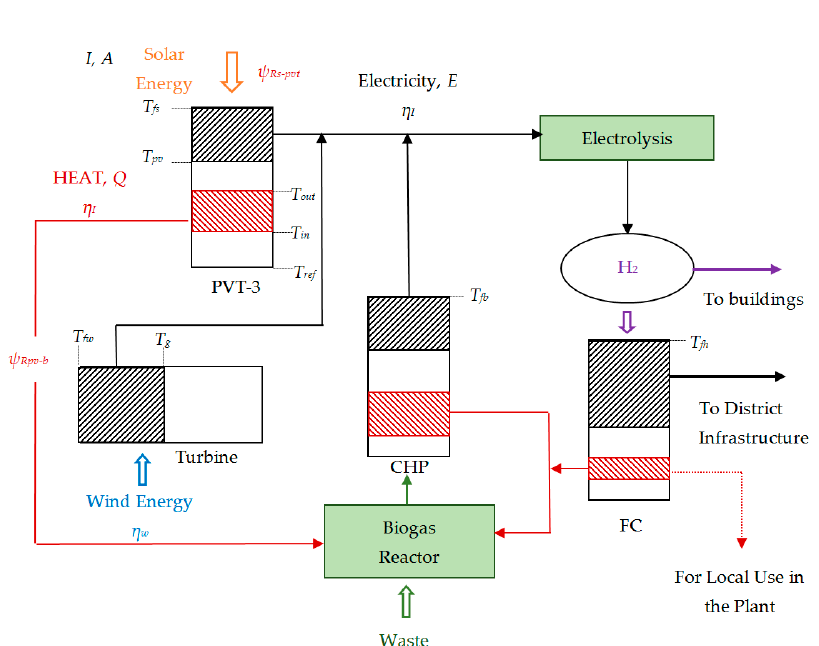
Figure 15. Exergy Flow Bars for the District Energy Plant of the Main Cycle Generating Hydrogen from Renewables for Power, Heat, and Cold Supply.